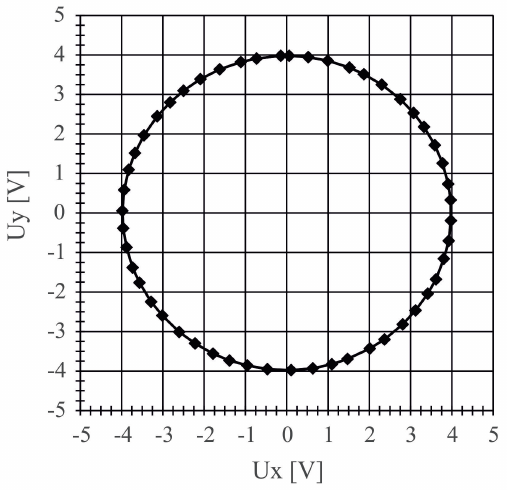
Figure 7. Output signals U x and U y from the interferometer after removal of the constant components and application of the Heydemann